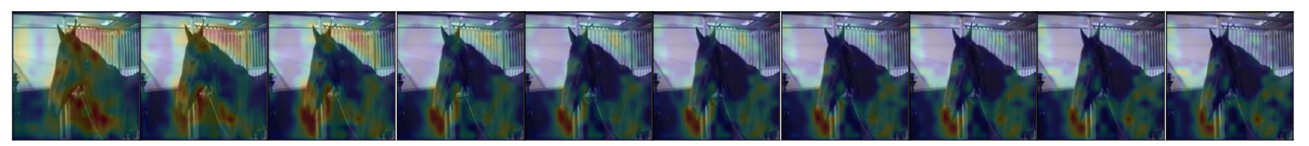
Figure 4. Ten frames from a sequence of a horse not in pain that was misclassified by human experts, correctly classified by the neural network. Overlaid on each video frame is an illustration of where in the video frame the neural network focused, based on color changes. From [117].